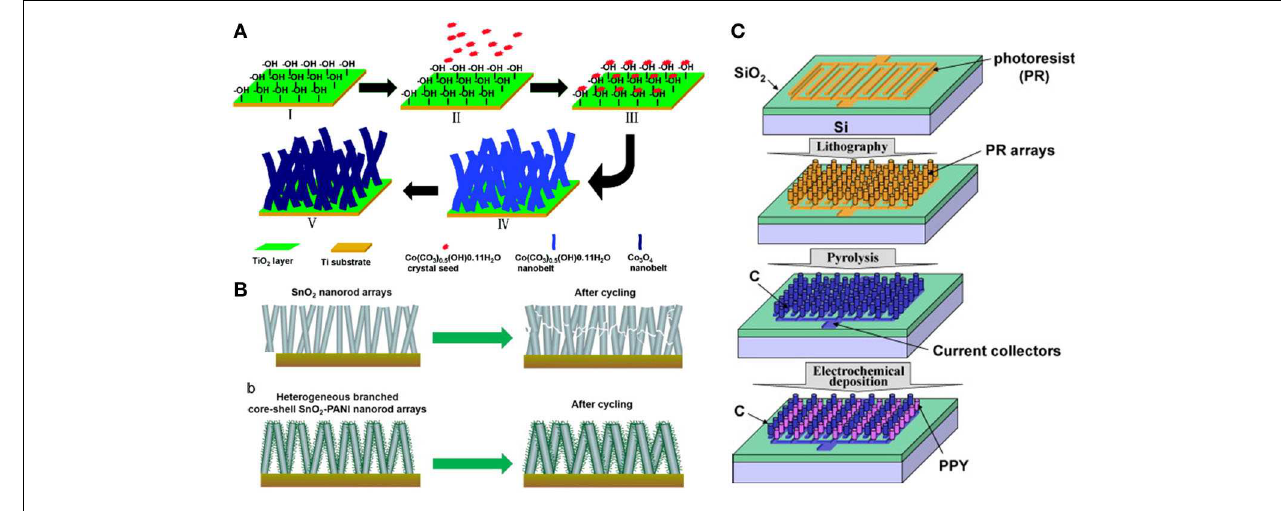
carbon/polypyrrole three-dimensional battery (Min et al., 2008). Reprinted with permission fromWang et al. (2010), Xu et al. (2014), and Min et al. (2008). Copyright 2010 American Chemical Society, 2014 Elsevier B.V., and 2007 Elsevier